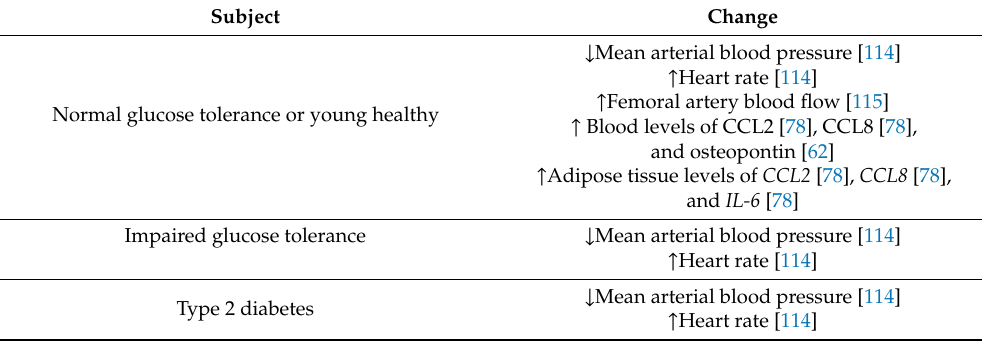
Table 3. Cardiovascular e ff ects of GIP in human studies. ↑ , increase; ↓